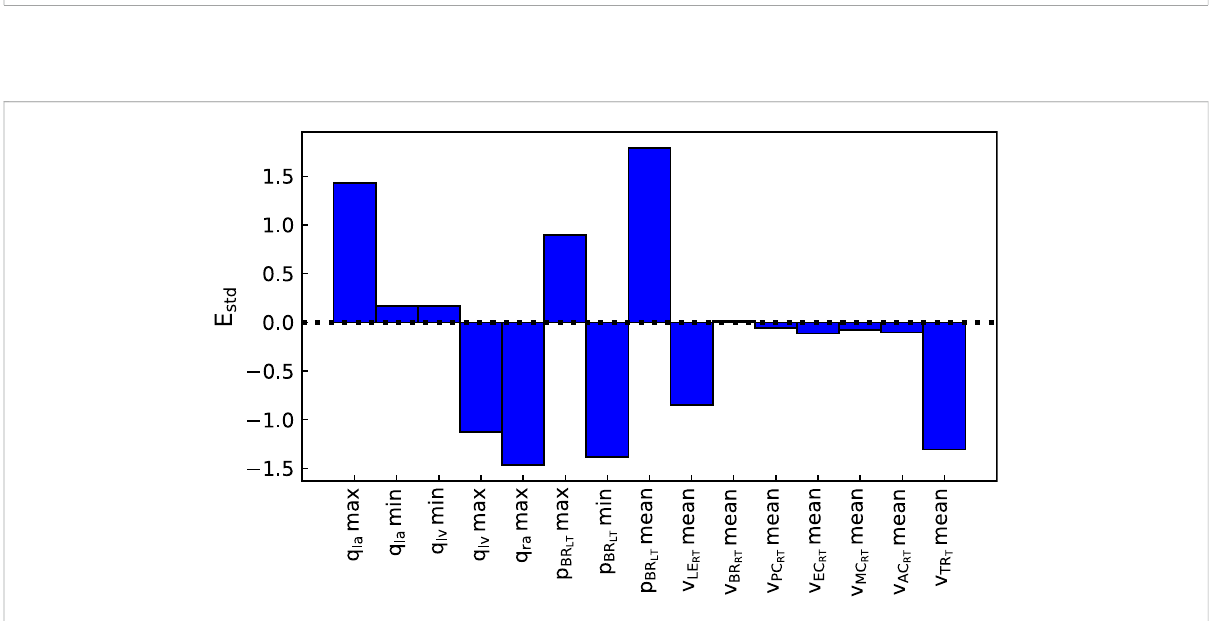
FIGURE 4 Normalised error between optimal model outputs ( f i ( θ )) and measured data ( ^ z i ) from the parameter identi fi cation pipeline for Patient 1 (normalised by σ i ). q la : left atrium volume, q lv : left ventricle volume, q ra : right atrium volume, p BR L : left brachial pressure, v LE RT : right leg terminal fl ow, fl ow, v PC fl ow, v EC fl ow, v MC v BR RT : right brachial terminal RT : right posterior cerebral terminal RT : right external carotid terminal RT : right middle cerebral terminal fl ow, v AC RT : right anterior cerebral terminal fl ow, v TR T : trunk terminal fl